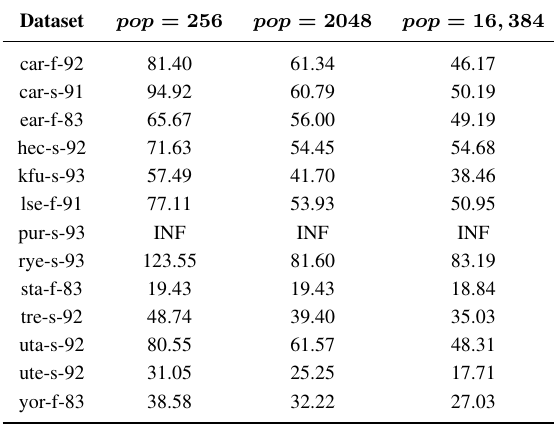
Table 7. Average difference (%) from the best reported solution in the bibliography with the genetic algorithm and a tournament selection size of population size/ 32 .